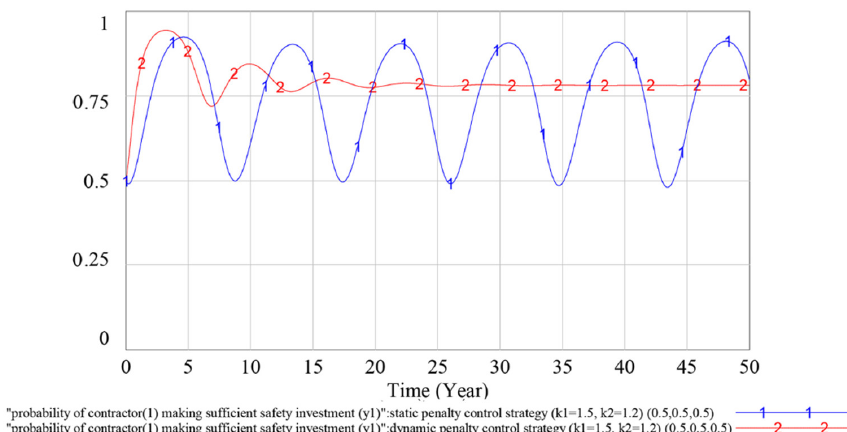
Figure 8. Influence of different penalty control strategies on contractor (1)’s strategy choices.